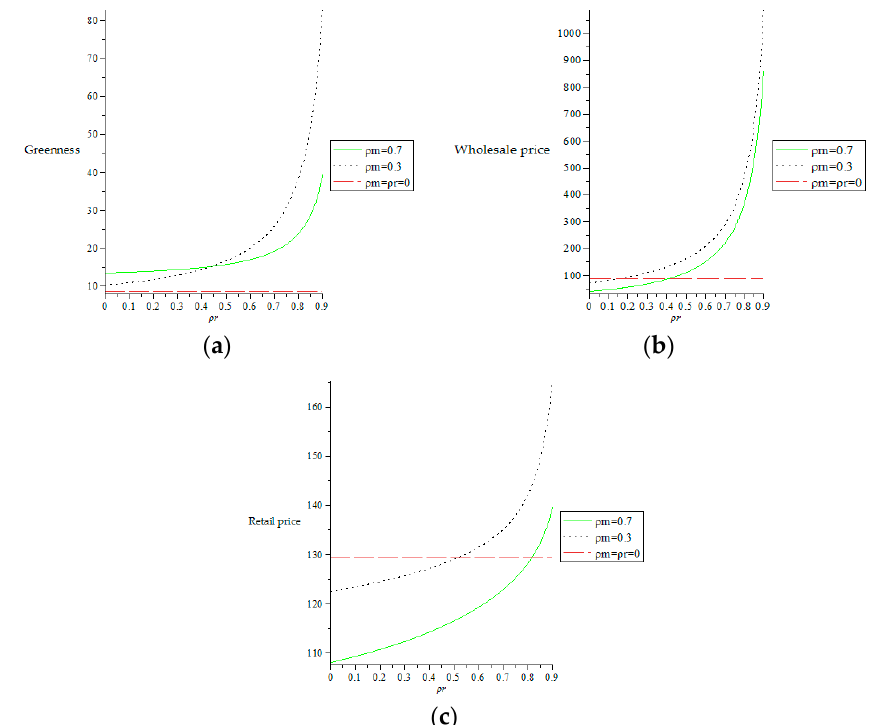
Figure 6. The effect of altruistic preference coefficients of two manufacturers and the retailer on the decisions of supply chain members. ( a ) The impact of altruistic preference coefficients of two manufacturers and the retailer on greenness. ( b ) The impact of altruistic preference coefficients of two manufacturers and the retailer on wholesale prices. ( c ) The impact of altruistic preference coefficients of two manufacturers and the retailer on retail